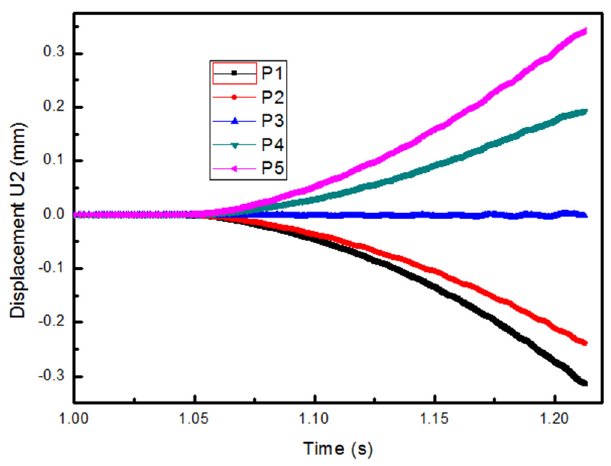
Figure 6. The axial displacement-time curve of the characteristic points (P1–P5).